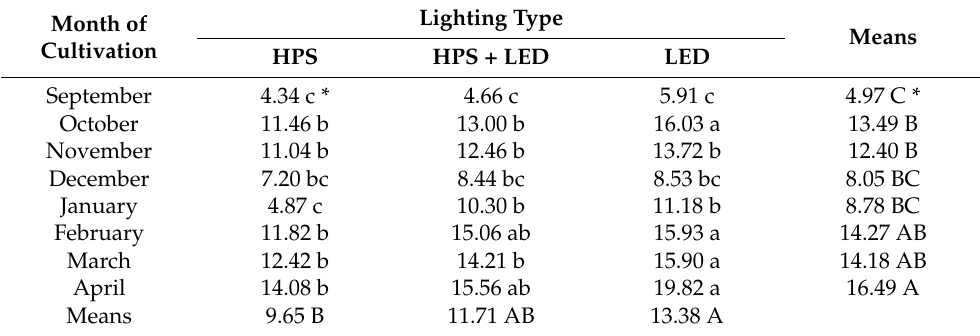
Table 1. Effect of lighting type on cucumber fruit yields from September to April (kg m − 2 ). Month